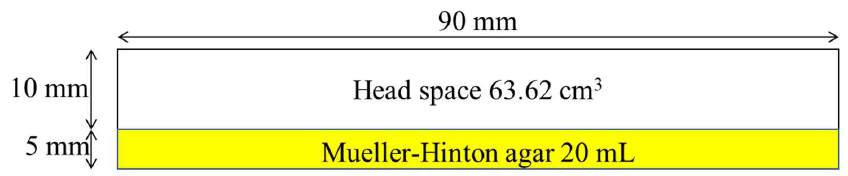
Figure 10. Dimensions of the Petri dishes filled with a fixed quantity of Mueller–Hinton agar, used for all the antibacterial tests.